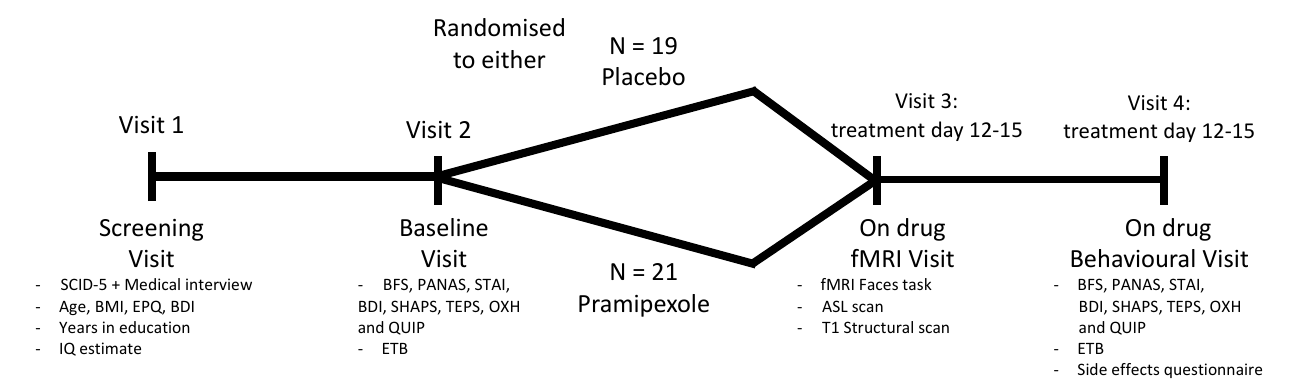
Figure 2. Flowchart describing the study design and intervention. SCID-5: Structured Clinical Interview for DSM-5; BMI: body mass index; EPQ: Eysenck personality questionnaire; BDI: Beck depression inventory; IQ estimate: Spot-the-word test; BFS: Befindlichkeitsskala; PANAS: positive and negative affect schedule; STAI: state-trait anxiety inventory; SHAPS: Snaith-Hamilton pleasure scale; TEPS: Temporal experience of pleasure scale; OXH: Oxford happiness questionnaire; QUIP: questionnaire for impulsive-compulsive disorders in Parkinson’s disease-rating Scale; ETB: Emotional Test Battery; ASL: arterial spin labelling.